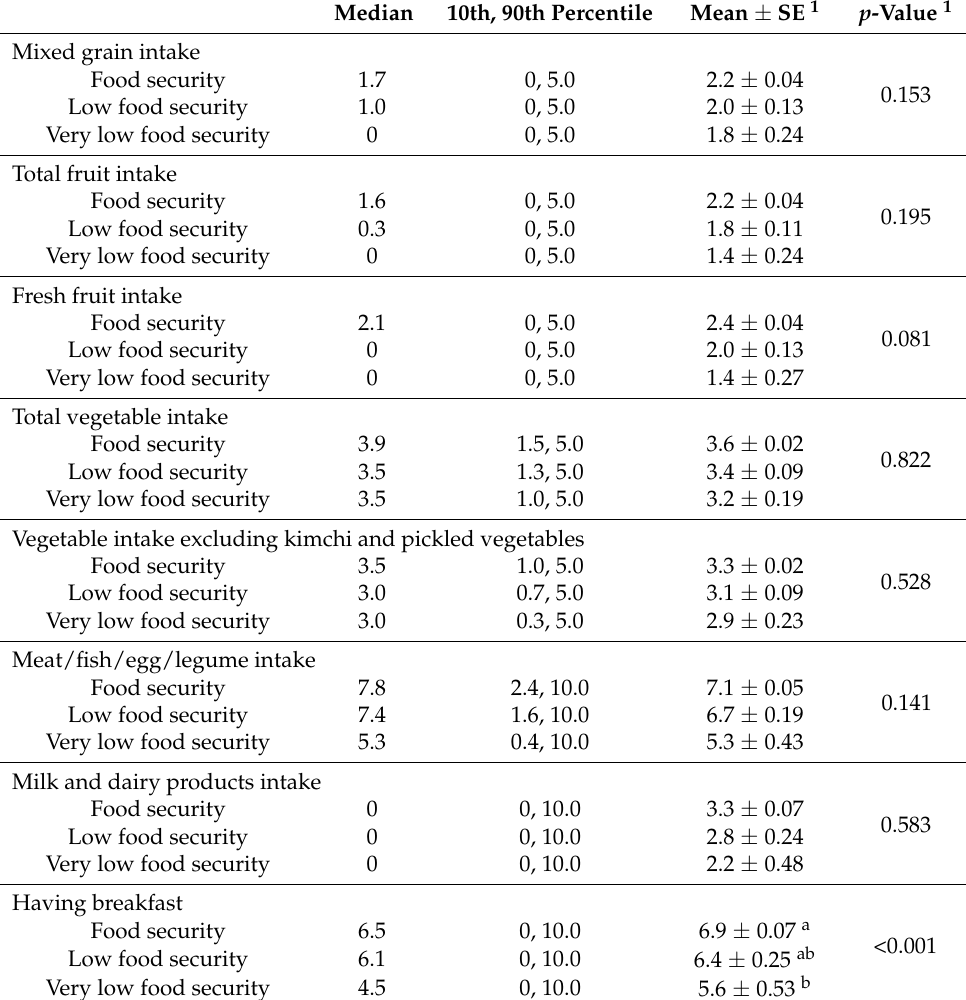
Table 3. Difference in means of KHEI item score according to household food security